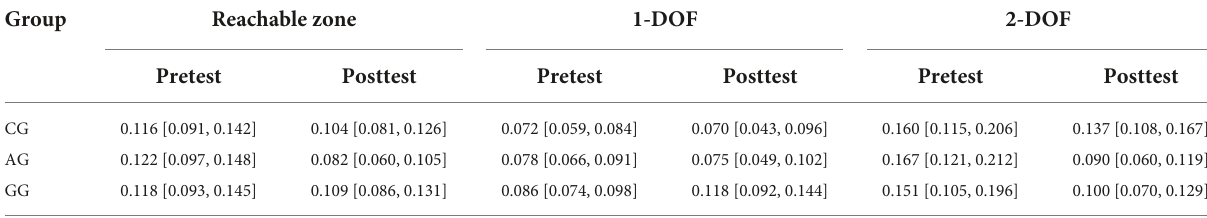
TABLE 3 Mean values and 95% confidence intervals (in square brackets) of UE according to regions, group, and phase.